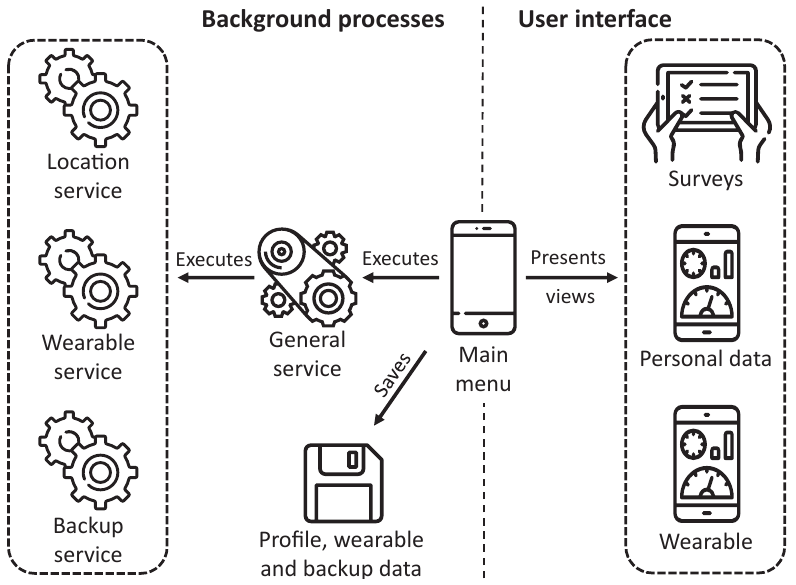
Figure 4. Architecture of the smartphone application designed.